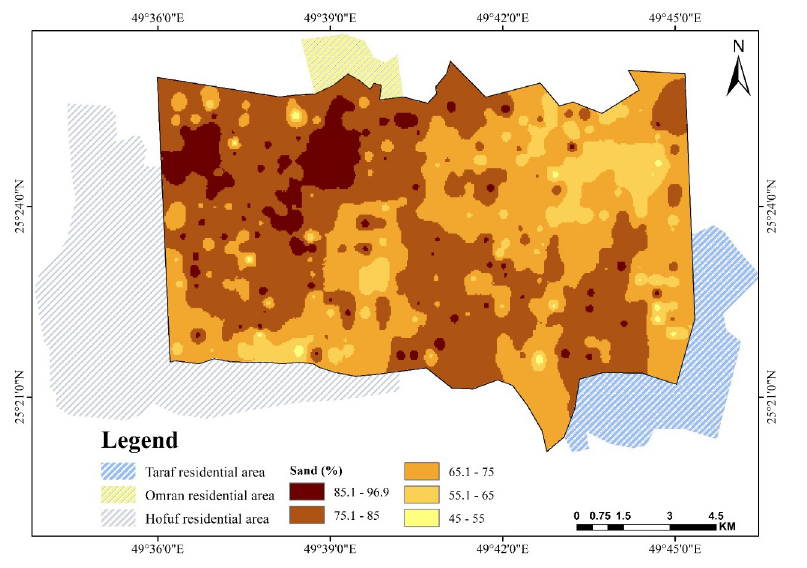
Fig 2. Spatial pattern of sand over